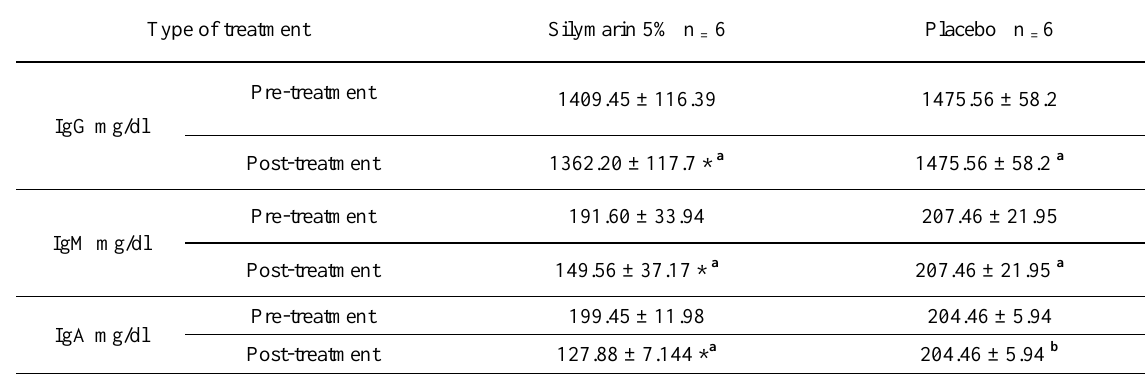
Table 2. Effects of silymarin 5% paste on serum immunoglobulins levels in HSU